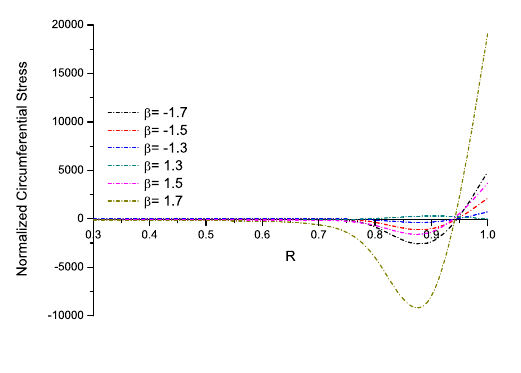
Figure 4: Normalized circumferential stress and radial coordinate for different values of β